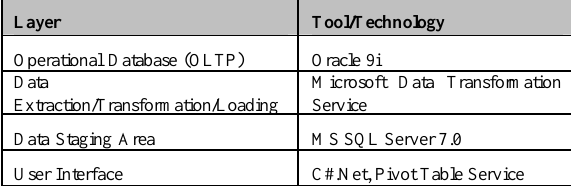
Table 3. Tool/Technologies